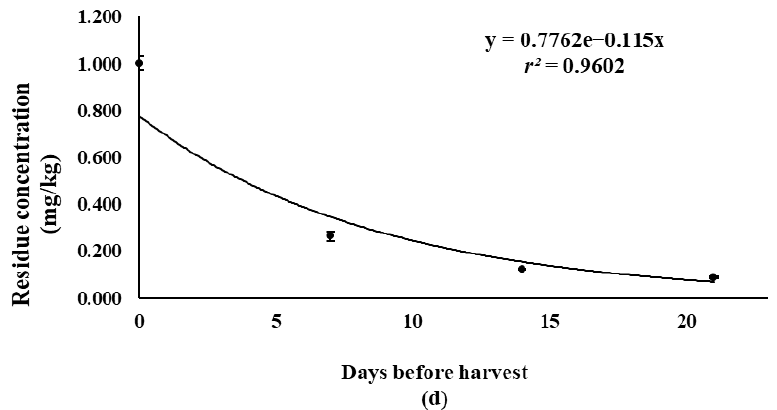
Figure 4. Dissipation patterns of bifenthrin residue in chives.